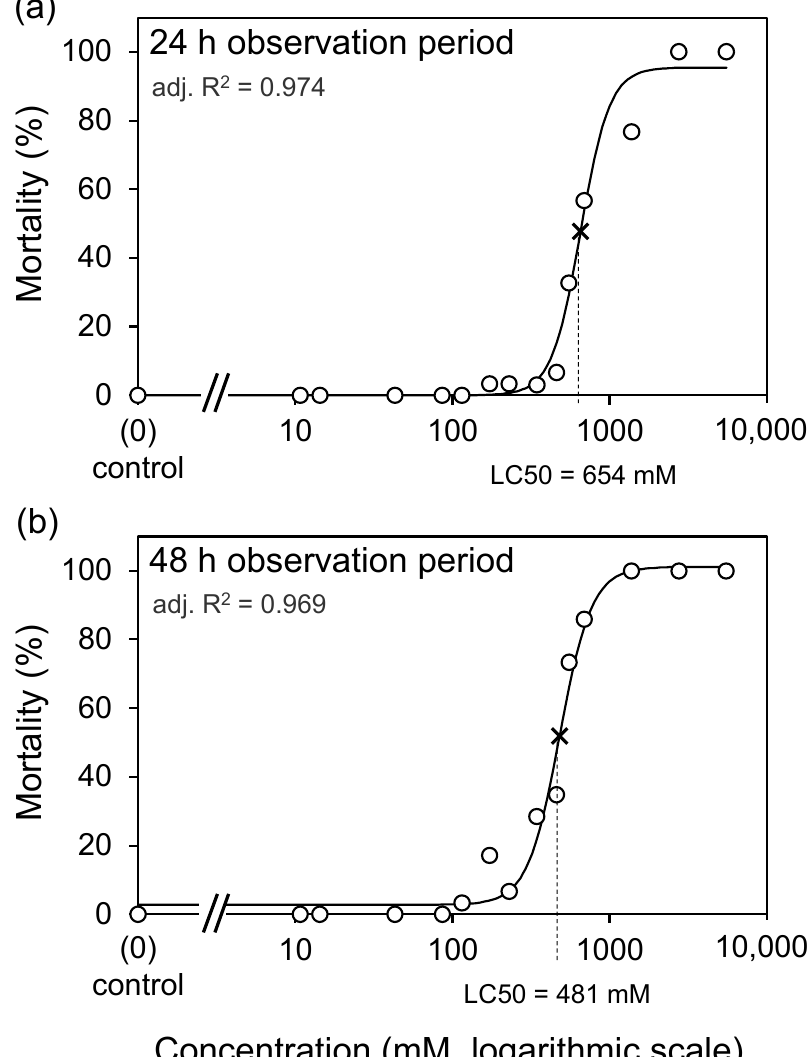
Figure 3. Concentration–response curves and LC 50 values for lithium chloride in the dog tick for 24 h ( a ) and 48 h ( b ) observation periods.